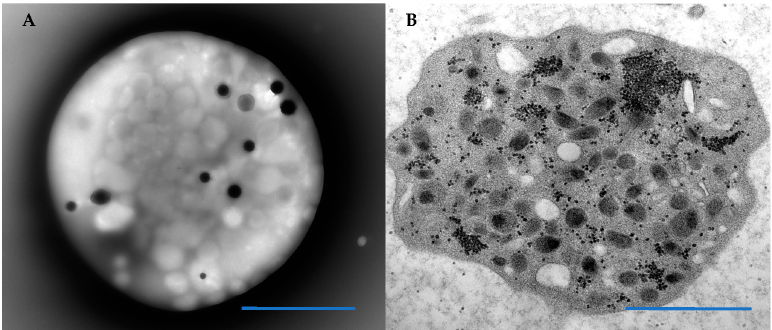
Figure 1. The ultrastructural morphology of platelets can be assessed by either a whole mounted, air-dried technique that allows enumeration of platelet dense granules. ( A ) A normal platelet with 10 dense granules. Platelets may also be sectioned in epoxy embedded buffy coat to evaluate organelle morphology and alpha granule content such as the platelet depicted in ( B ) that has numerous alpha granules and aggregates of black granular glycogen. Blue Bars = 1 micron.